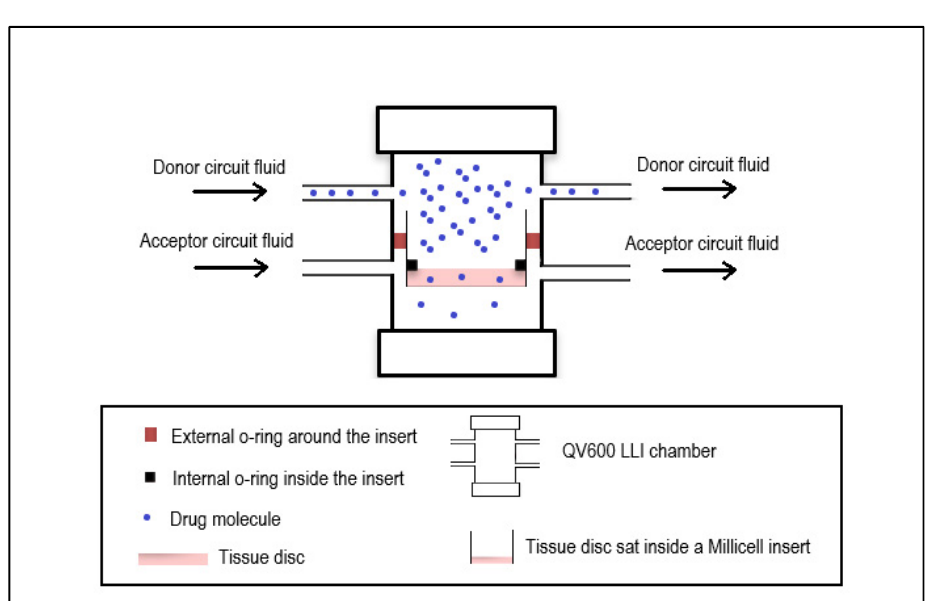
Figure 1. Adaptation of the QV600 LLI (Kirkstall Ltd.) microfluidics cell culture chamber to hold ex vivo tissue.